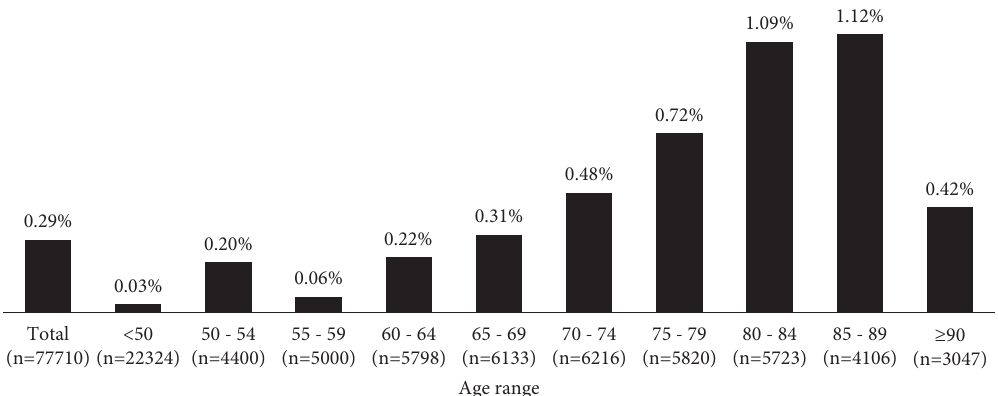
Figure 2: Total incidence of hospitalizations between 2000 and 2019 of patients with Parkinson’s disease admitted to the intensive care units (ICUs) included in the study, stratified by the age group. A total of 1304 patients younger than 18 years and 371 with no record of age in the database were not included in the